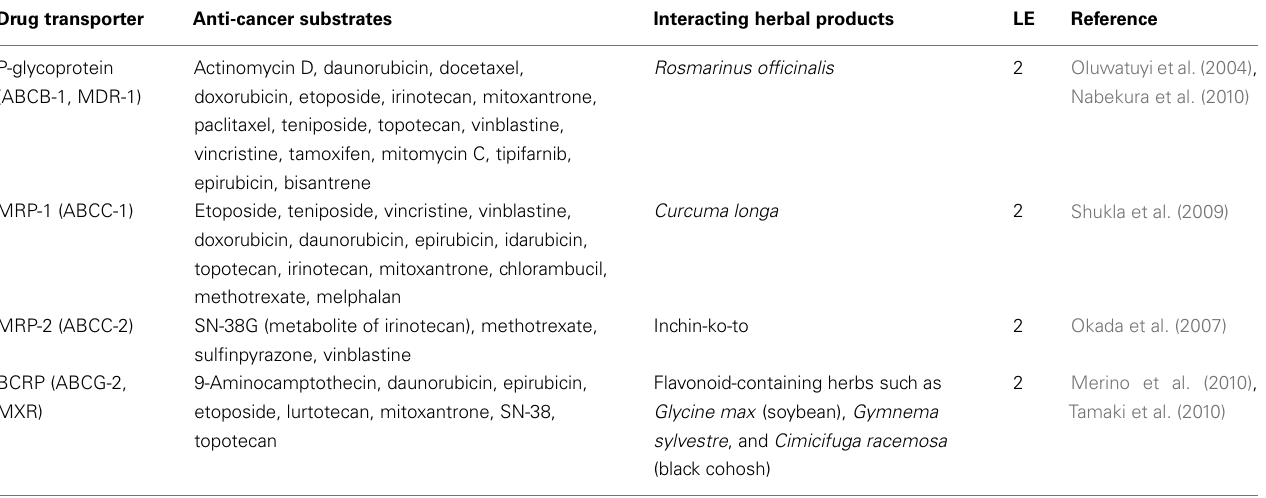
Table 4 | Influence of herbal products on transport